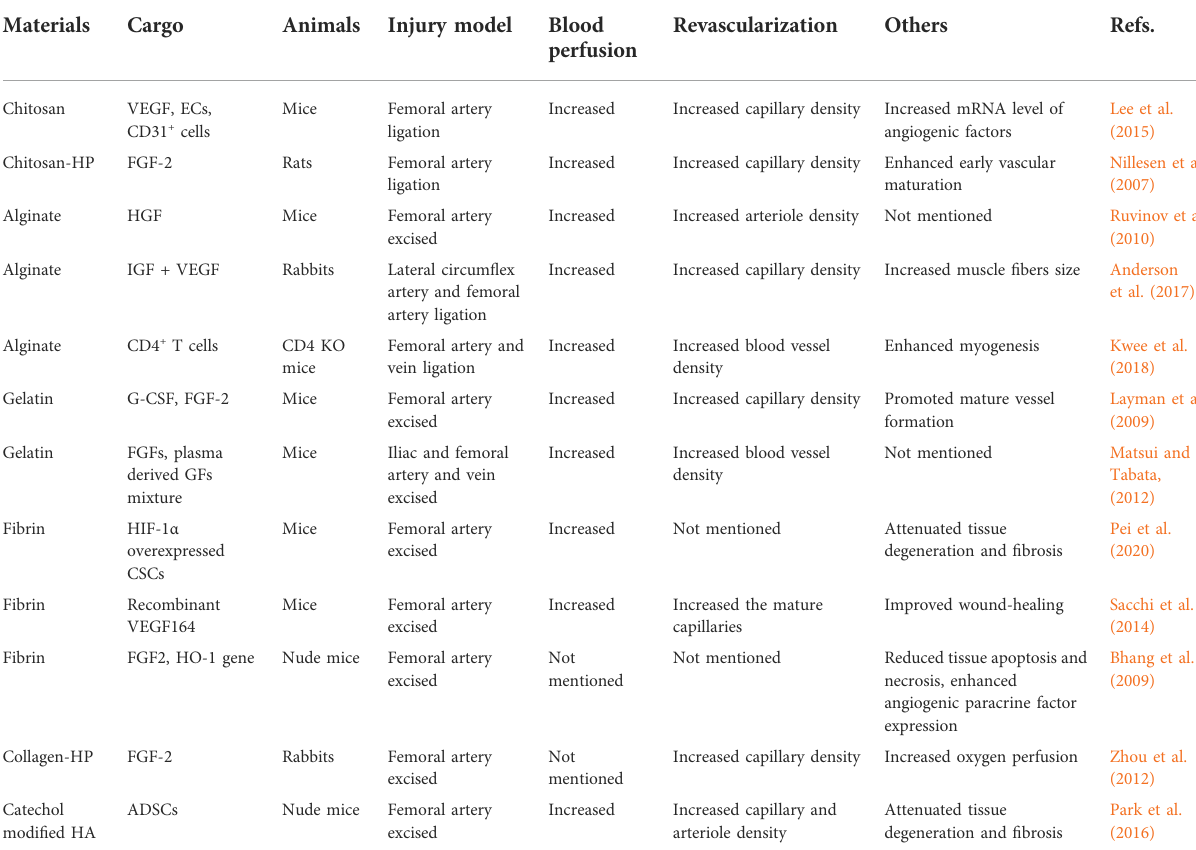
TABLE 2 Preclinical studies of natural hydrogels for